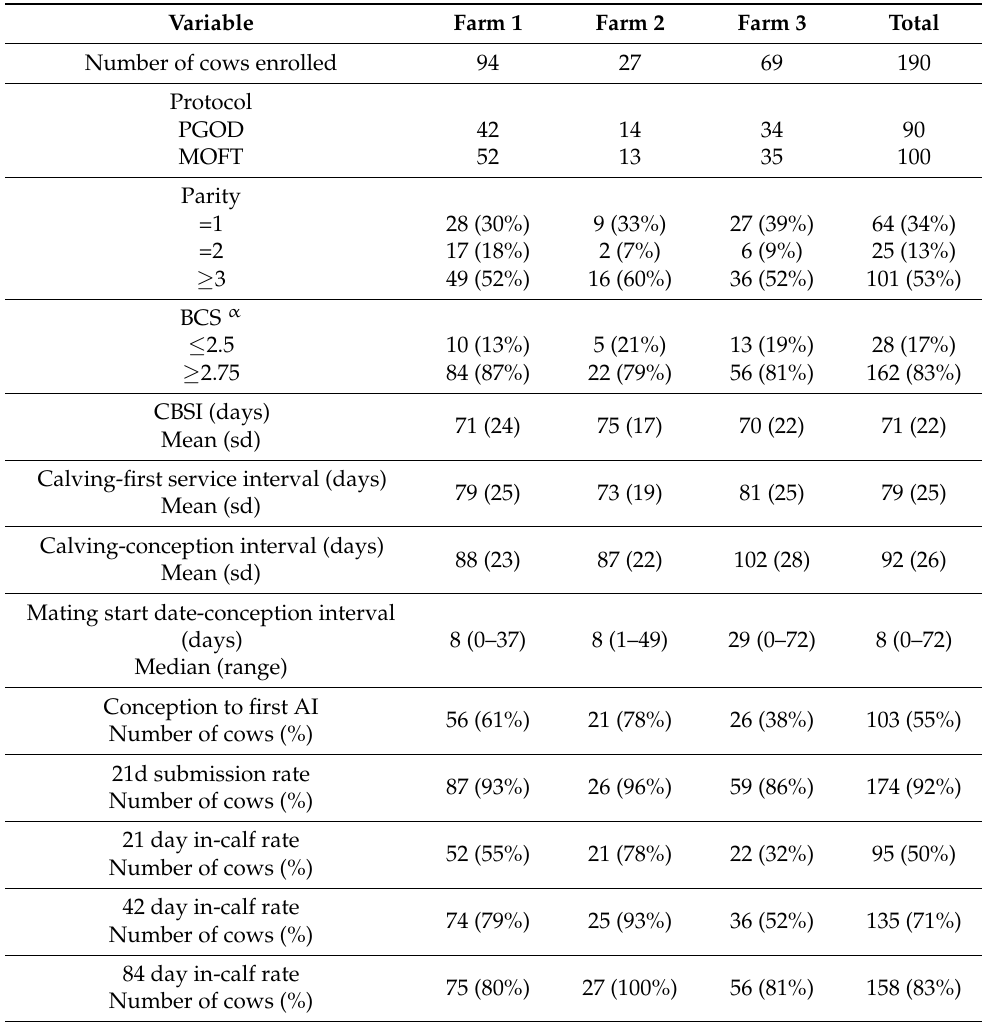
Table 3. Summary information of 190 cows recruited to receive either a modified Ovsynch or a prostaglandin based protocol at the mating start